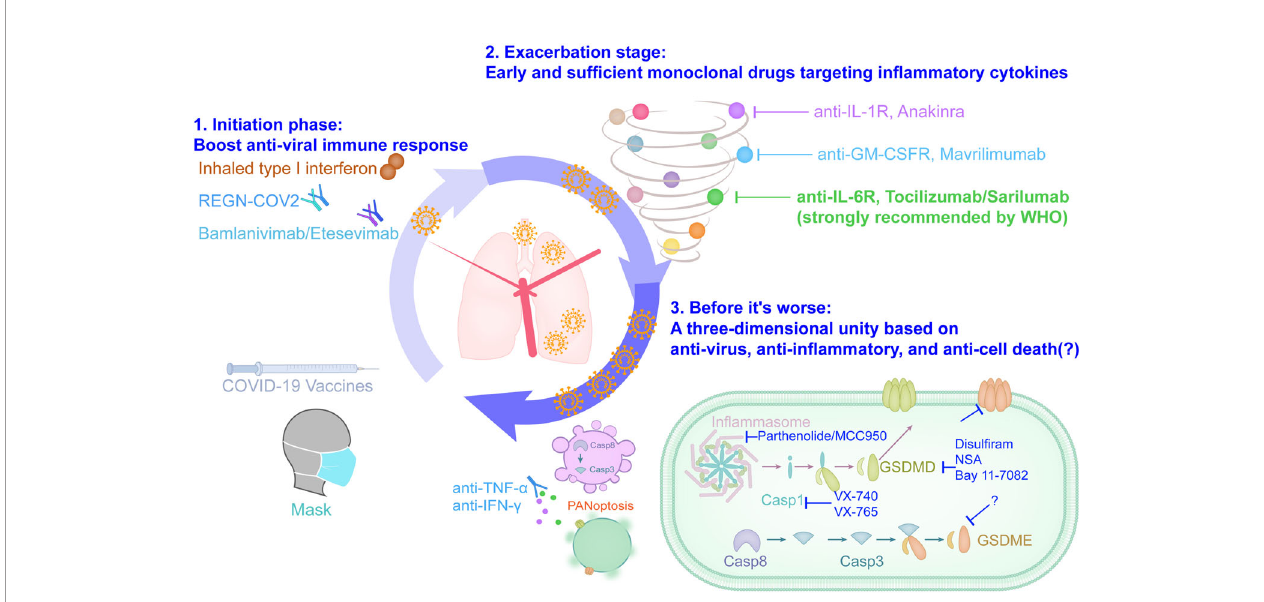
FIGURE 2 | The three-dimensional integrated solution based on anti-viral, anti-in fl ammatory and anti-cell death slows down the ARDS clock of severe